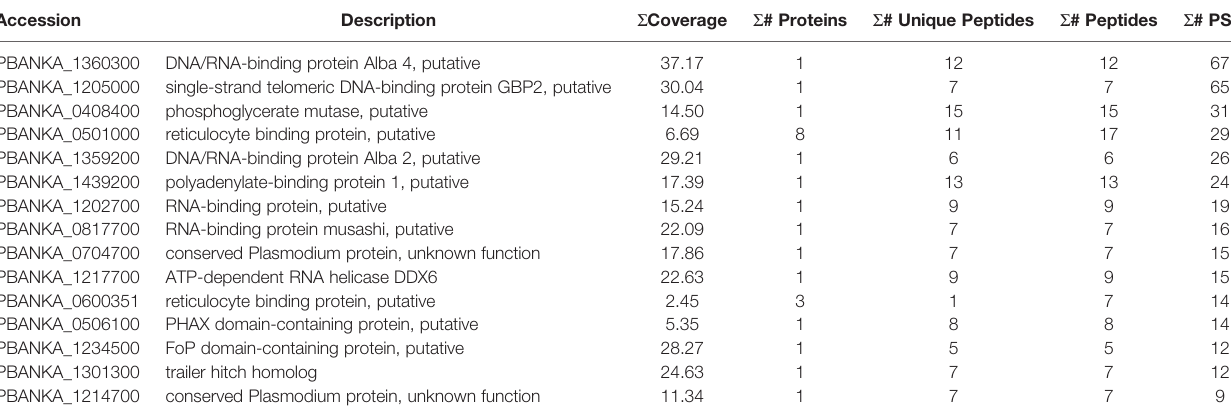
ProteinswereextractedfromGBP2::mCherryschizont-andgametocyte-enrichedculturesafterculturingfor22h.Proteinswithatleastthreepeptidespectralmatchesandafoldchange ≥ 2.5 compared with the controls are listed. Control experiments comprising immunoprecipitation in wild-type P. berghei ANKA using anti-mCherry beads coupled to mass spectrometry andGBP2::mCherry usinganti-GFPbeads coupledtomassspectrometry. Experiments were performedin triplicate. Thedisplayedresultsarethesumofthreeindependent